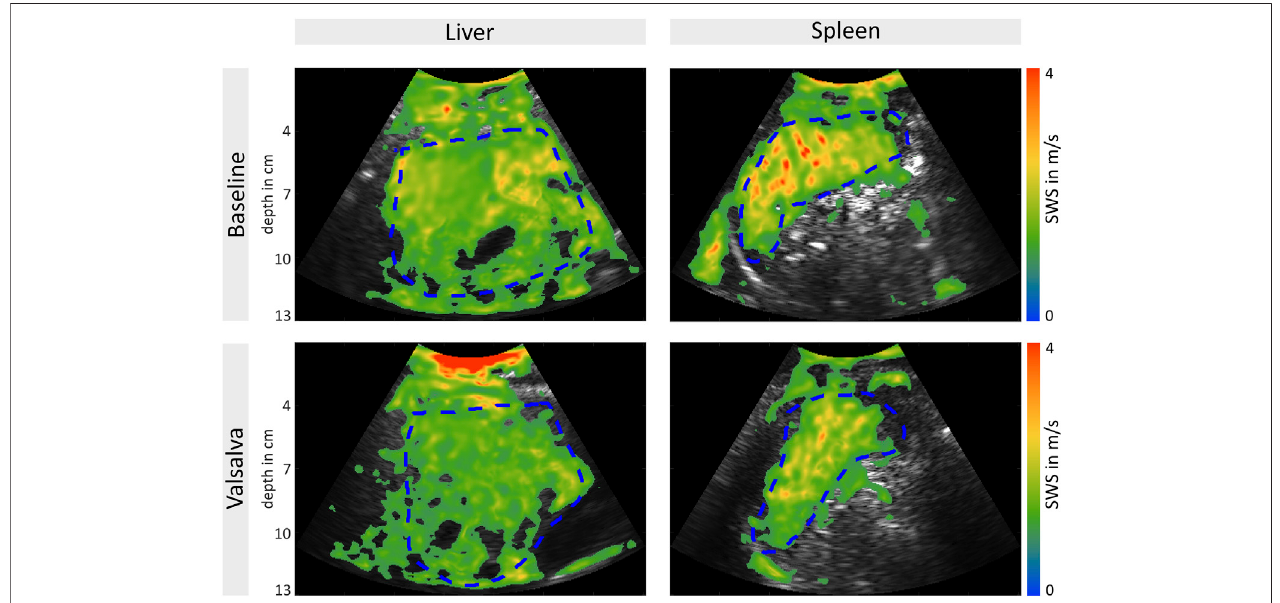
FIGURE 2 | Measurement of liver (A) and spleen (B) shear wave speed (SWS) under baseline conditions (above) and during the Valsalva maneuver (below). RepresentativeB-mode-imageswithelastogramoverlay showing a decreaseinSWS duringthe Valsalvamaneuver.Regions ofinterestare marked witha dashedblueline.